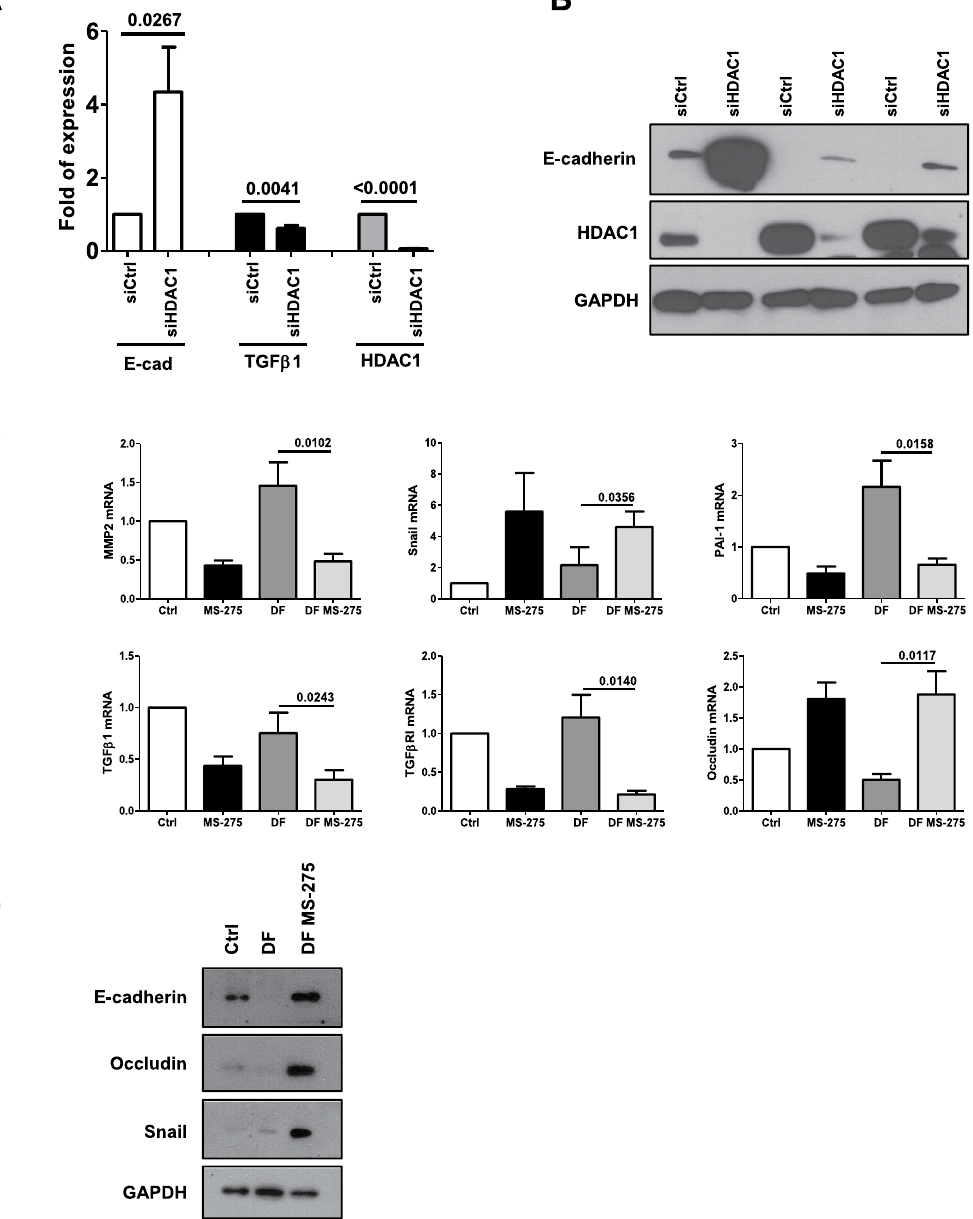
Figure 3. Effect of HDAC1 siRNA silencing on E-cadherin and TGF β 1 expression in MCs and effect of MS- 275 in blocking MMT induced by exposure to PD fluid. ( A ) Quantitative RT-PCR was performed on total RNA from MCs transfected with either control (siCtrl) or specific HDAC1-targeting siRNAs (siHDAC1). Expression of E-cadherin, TGF β 1, HDAC1 was evaluated. Bars represent means ± SEM of 5 experiments. ( B ) Western blots showing the expression of E-cadherin and HDAC1 in total cell lysates of MCs from three different PD patients transfected with either control or specific HDAC1-targeting siRNAs. GAPDH expression was evaluated as a loading control ( C ) Effect of MS-275 on MMT induced by exposure to PD fluid. Quantitative RT-PCR was performed on total RNA from epithelial-like MCs treated for seven days with stay safe balance 4.25% (used at a concentration of 1:1 with complete 199 Medium). Alternatively, cells were treated for four days with stay safe balance 4.25% (used at the same concentration as before) and then treated with the same PD fluid in the presence of MS-275 for three more days. As a control, MCs were left untreated for four days and then treated with MS-275 or DMSO for the last three days. Expression of MMP2, Snail, PAI-1, TGF β 1, TGF β RI, Occludin was evaluated on total RNA by qRT-PCR. Bars represent means ± SEM of 4 experiments ( D ) Western blots showing the expression of E-cadherin, Occludin and Snail in total cell lysates of MCs treated as above. GAPDH expression was used as a loading control. Representative experiment of 4 performed. P < 0.05 was considered